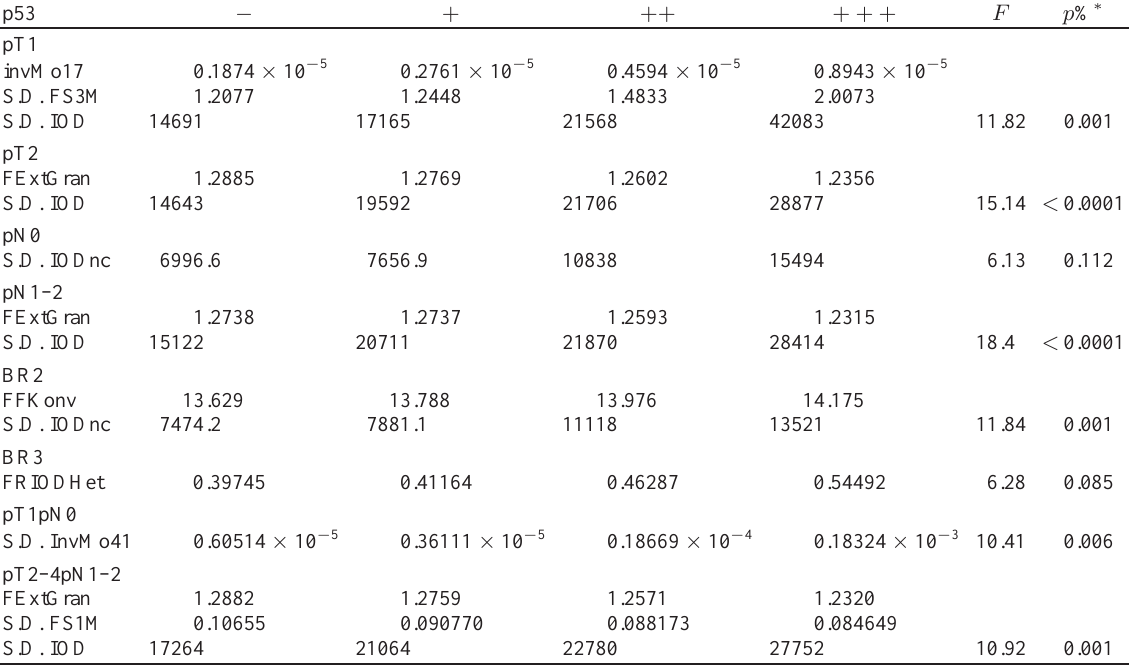
Table 6 Nuclei with different p53 expression in p53 positive tumours in prognostic